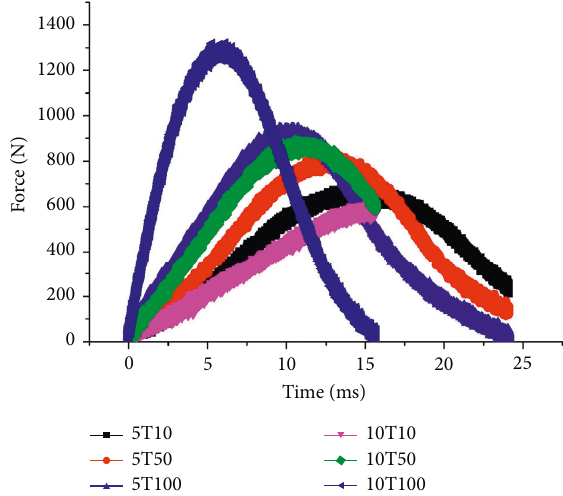
Figure 3: 5T10, 5T50, 5T100, 10T10, 10T50, and 10T100 stress- strain